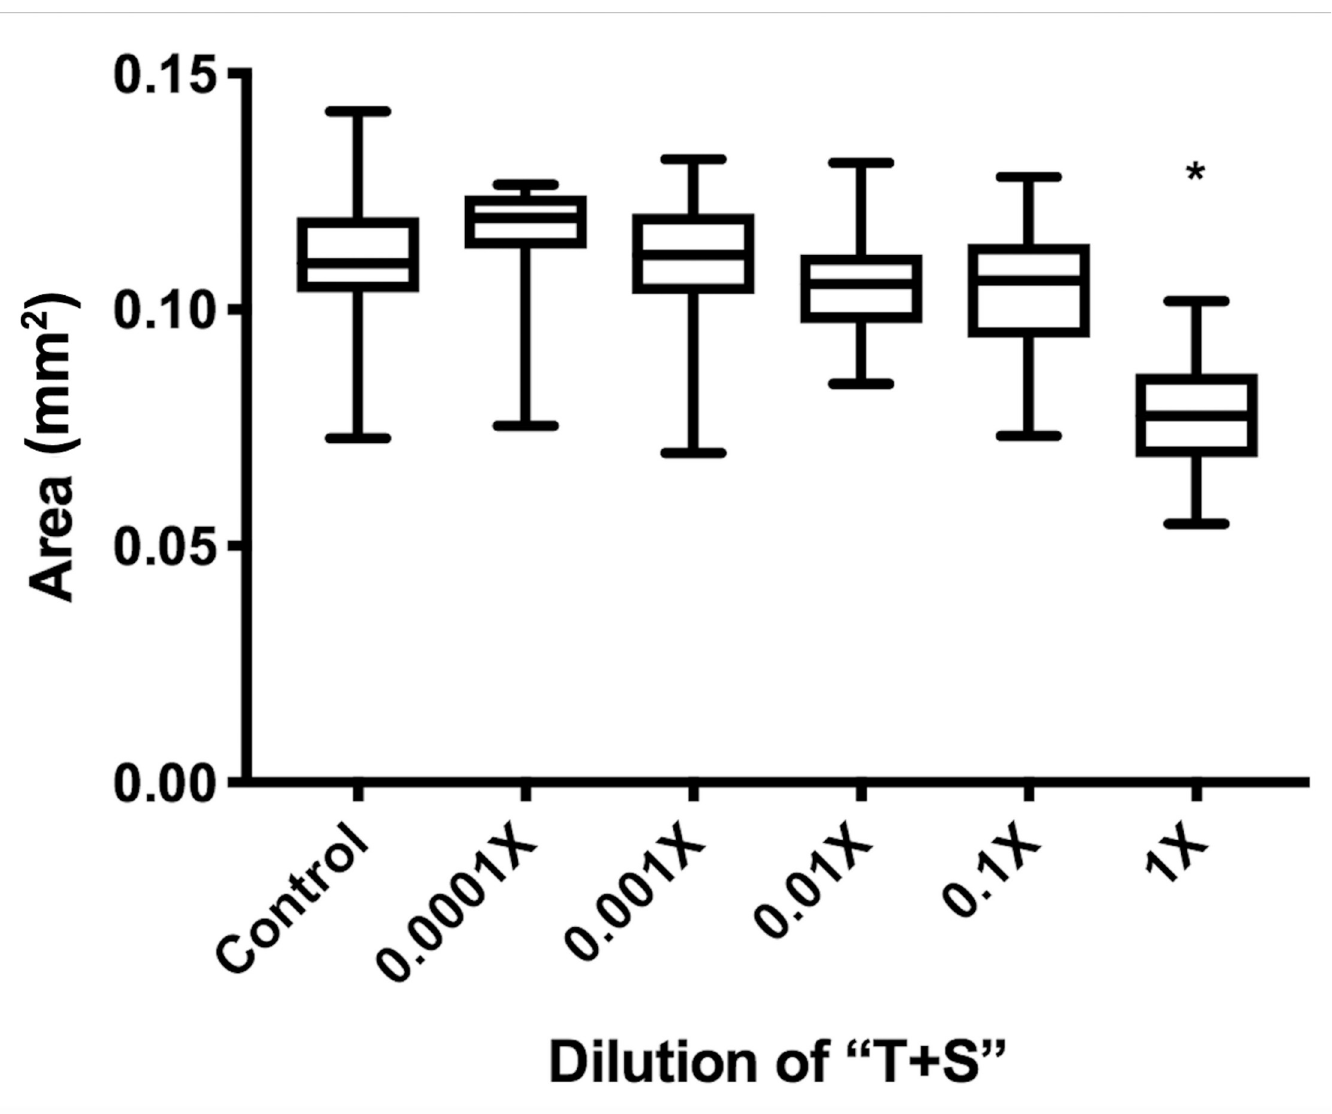
Fig 2. Growth of C . elegans is stunted by exposure to “T+S”. Area of C . elegans was measured in young adult, day 5 nematodes exposed to varying concentrations of “T+S” from laid egg to adulthood (day 5) to assess effects on growth and body size. C . elegans were imaged and then measured using Image J/FIJI software. n = 6 independent trials with 10 worms at each concentration (60 worms for each concentration total) were analyzed using a 2-way ANOVA. Area: F 5,136 = 13.14, p < 0.0001. t- test: control vs. 1X: p < 0.0001. https://doi.org/10.1371/journal.pone.0238637.g002 of “T+S” (n = 190, p < 0.0001), while this did not occur with simultaneous exposure with para- quat, a known oxidative agent (n = 122, p = 0.93, Fig 3). Chronic, but not acute, “T+S” exposure decreases locomotion L4 worms (96 hours old raised at 20˚C with standard OP50 E . coli food source) raised on 1X “T+S” for 72 hours (from egg to L4) and then placed on control plates for 24 hours, showed decreased locomotion, as measured by the number of full sinusoidal body bends completed in 30 seconds (n = 135, p = 0.0003, Fig 4). However, this effect was not found in worms exposed for 24 hours beginning at the young L4 stage (n = 132, p = 0.5793).